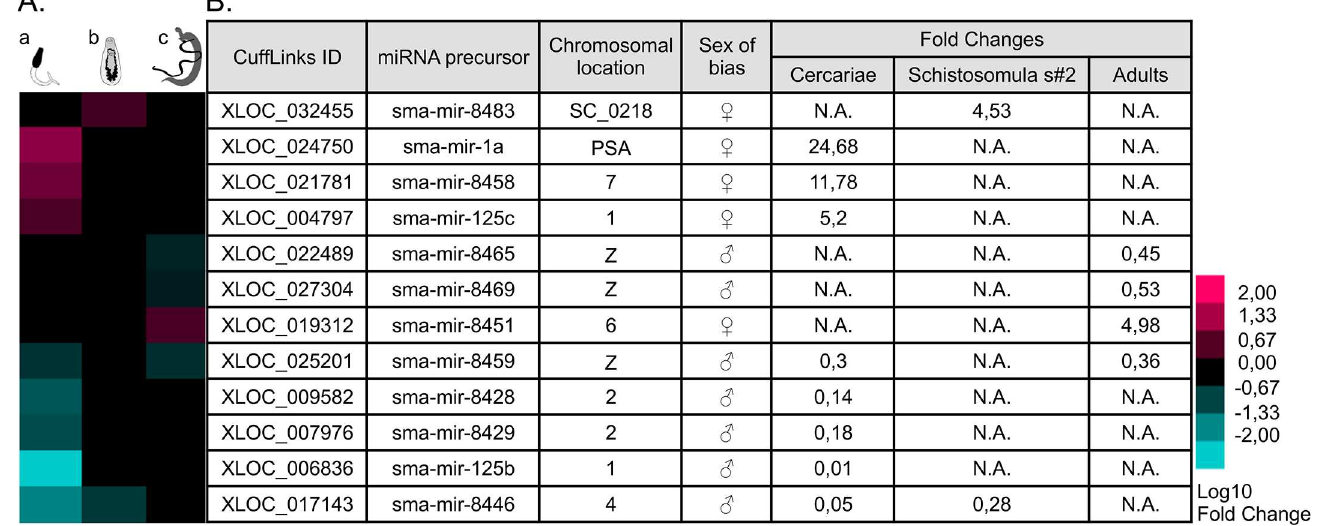
Fig 5. Overview of the 12 sex-biased miRNAs through three stages of the schistosome lifecycle (a: cercariae,b: schistosomula s#2, c: adults). (A) General clustering of sex-biased miRNA expression: seven male-biased miRNAs were detected (in blue), five were female-biased (in pink). (B) Table of sex-biased miRNA precursors IDs, chromosomal location and expressionbias. Four miRNAs were located on sex chromosomes: three on the Z-specific regions(as defined by Protasio et al . [4]) were overexpressed in males. Key : PSA = PseudoAutosomalRegion , Z = Z-specific gene , N . A . = no sex-bias of expression